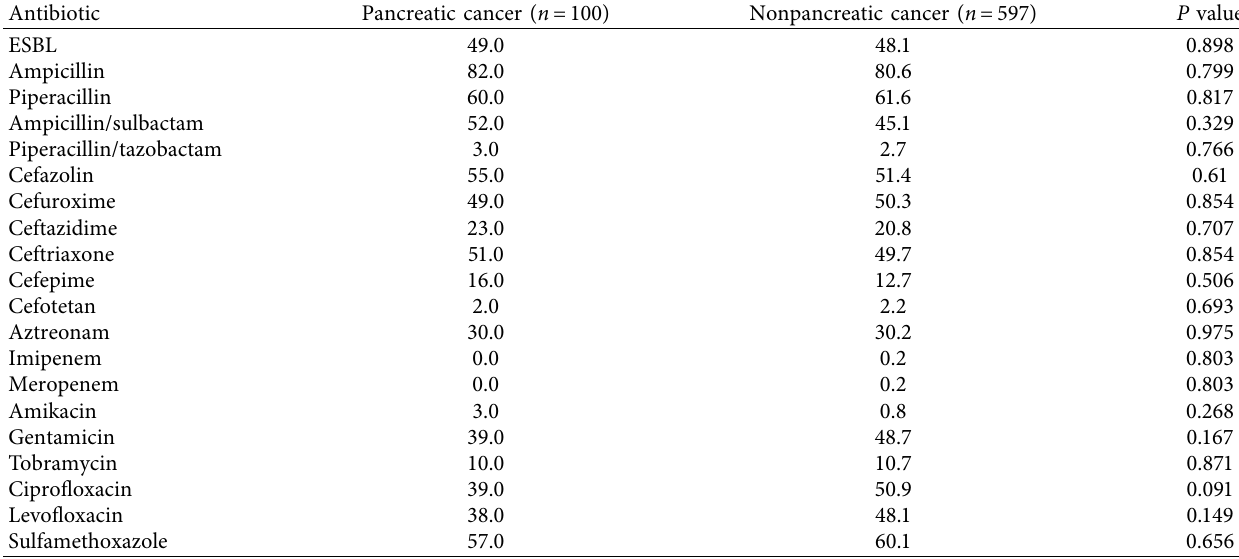
Table 5: Analysis of drug resistance of E. coli BSI in pancreatic cancer and nonpancreatic patients.